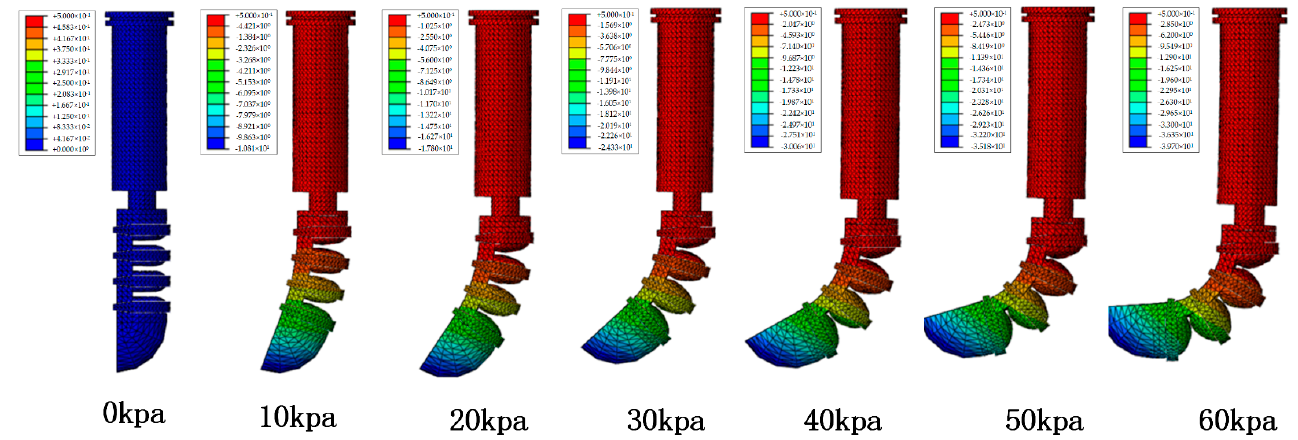
Figure 8. Simulation results of the bending of the distal phalanx of the thumb.